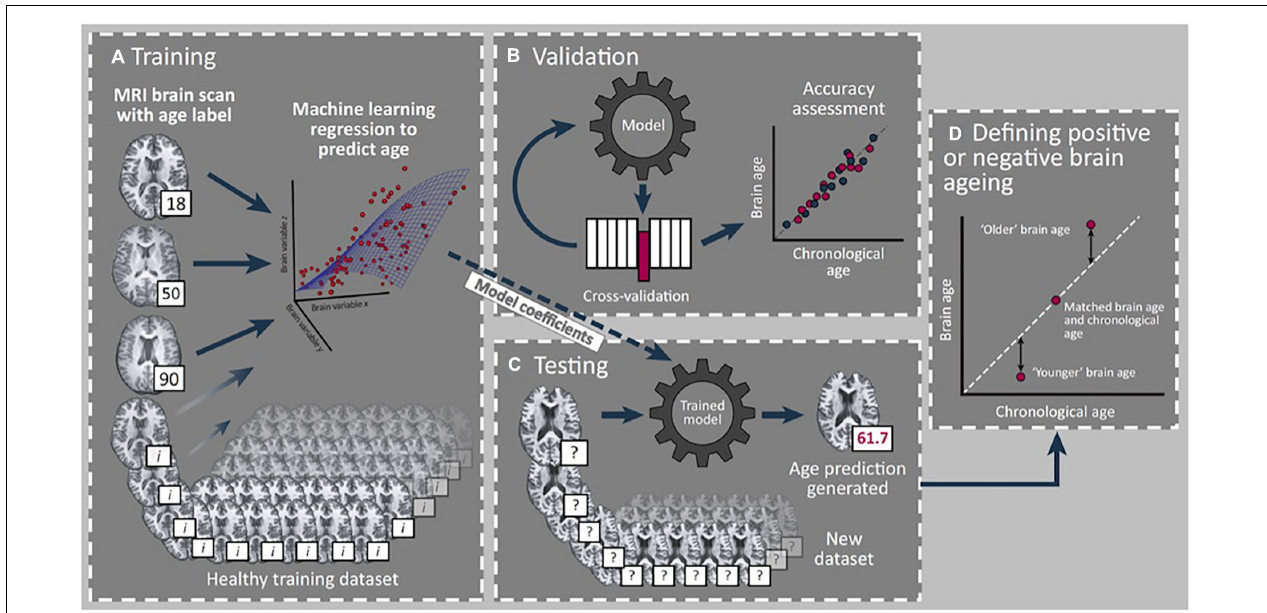
FIGURE 1 | Summary of brain age prediction using a supervised machine learning process. (A) Structural T-1 MRI scans labeled with chronological age from a training set of healthy individuals are loaded into a machine learning regression model. (B) Validation of model accuracy is conducted using cross-validation methods from a portion of the original dataset excluded from the model. Model generated predicted age values are compared with actual age values to determine model accuracy. (C) Model coefficients from the trained model are applied to a new test dataset to determine individual brain age prediction (61.7 years in this example). (D) A standardized metric for statistical comparison is created (brain-predicted age difference) by subtracting chronological age from predicted age to reflect rate of brain aging, with positive and negative values indicating older and younger brains, respectively. * Reprint permission from Elsevier from Trends in Neuroscience, 40 (12), Cole J. H. and Franke K., Predicting age using neuroimaging: innovative brain ageing biomarkers, 681–90,